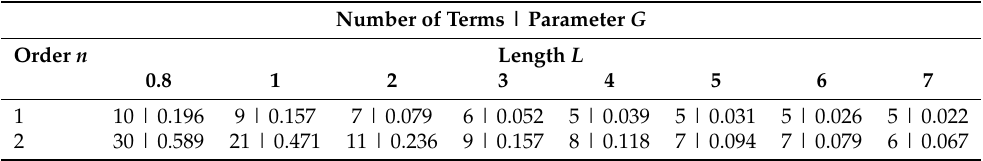
Table 2. Number of terms necessary to evaluate the sum in (47a) with absolute and relative errors smaller than 10 − 15 , for each length L of the beam and for the first two orders of the buckling load. It also shows the constant G for each case. The parameter b is equal to